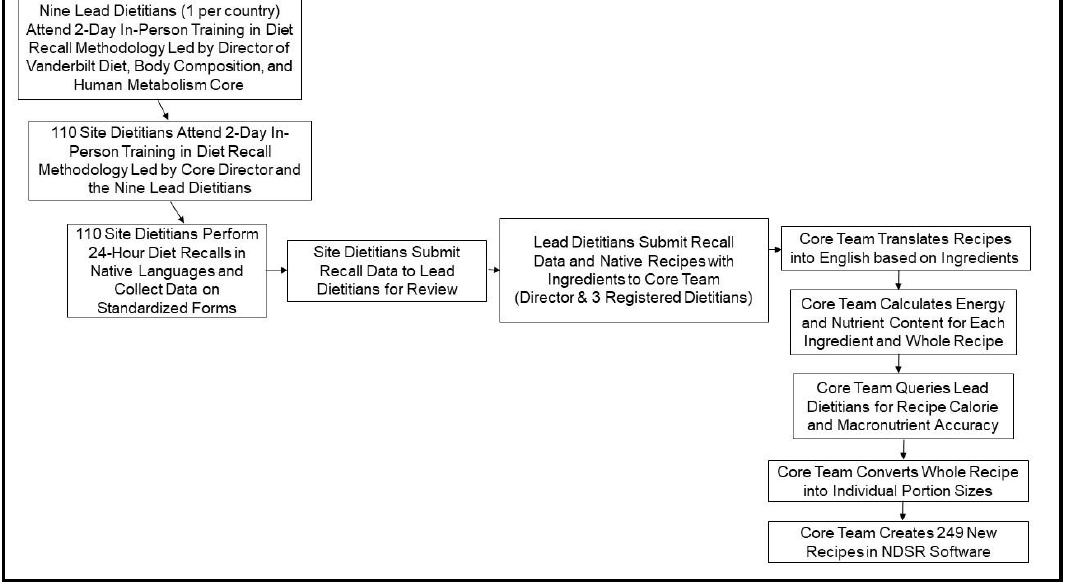
Figure 1. Process of study diet data collection of 1833 24-hr recalls from 9 countries and diet data entry by Vanderbilt Core team into Nutrition Data System for Research (NDSR) database.